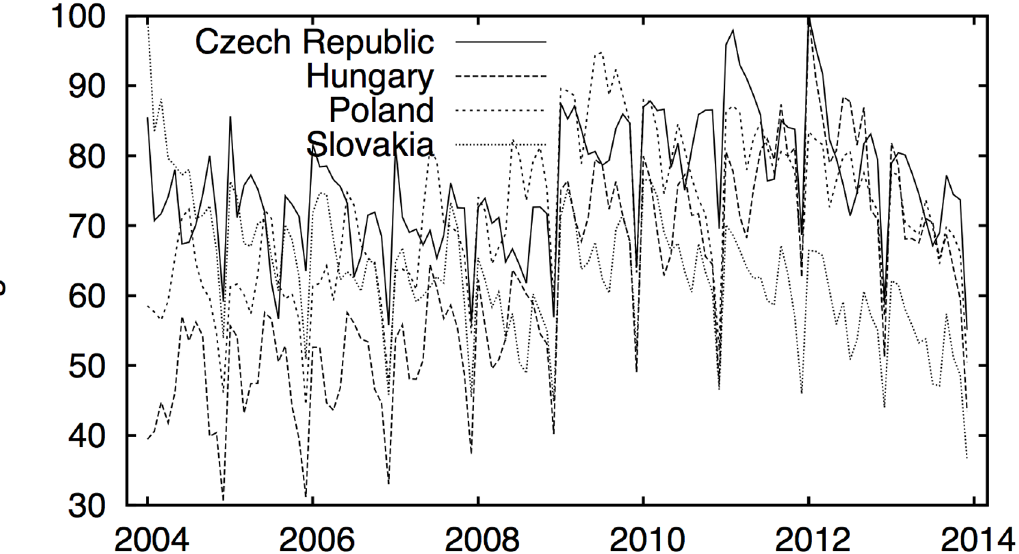
Fig 2. Google search queries for the job-related terms in the Visegrad countries. The patterns are again quite heterogenous, and the connection between the Google searches and the unemployment rates can be observed for the Czech and Hungarian rates. For the other two, the connection is not visible by the naked eye. Detailed treatment of the interconnections is given in the Results section of the text. Google data are registered trademarks of Google Inc., used with permission.